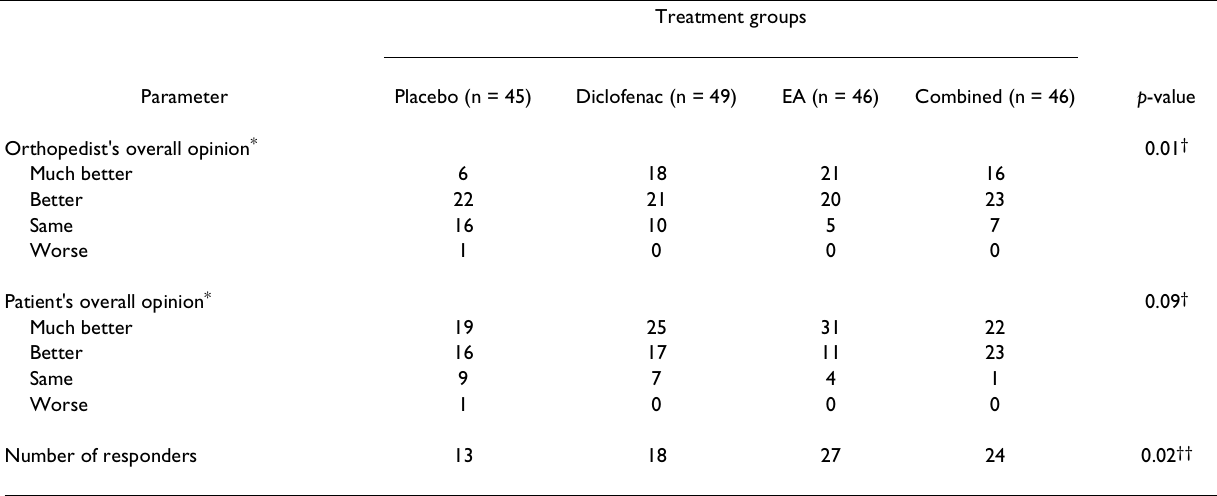
Table 5: Overall opinions of change and number of responders evaluated at week 4.